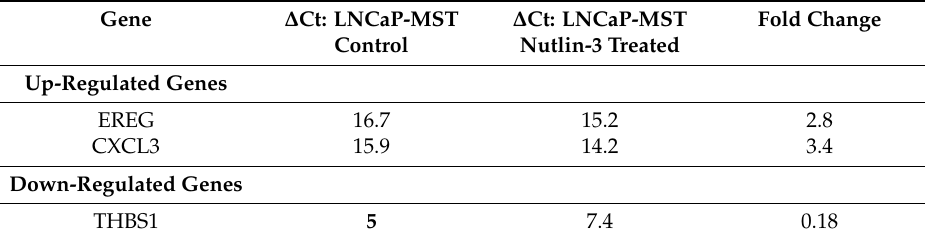
Table 5. Analysis of qRT-PCR in LNCaP-MST cells after Nutlin-3 treatment.